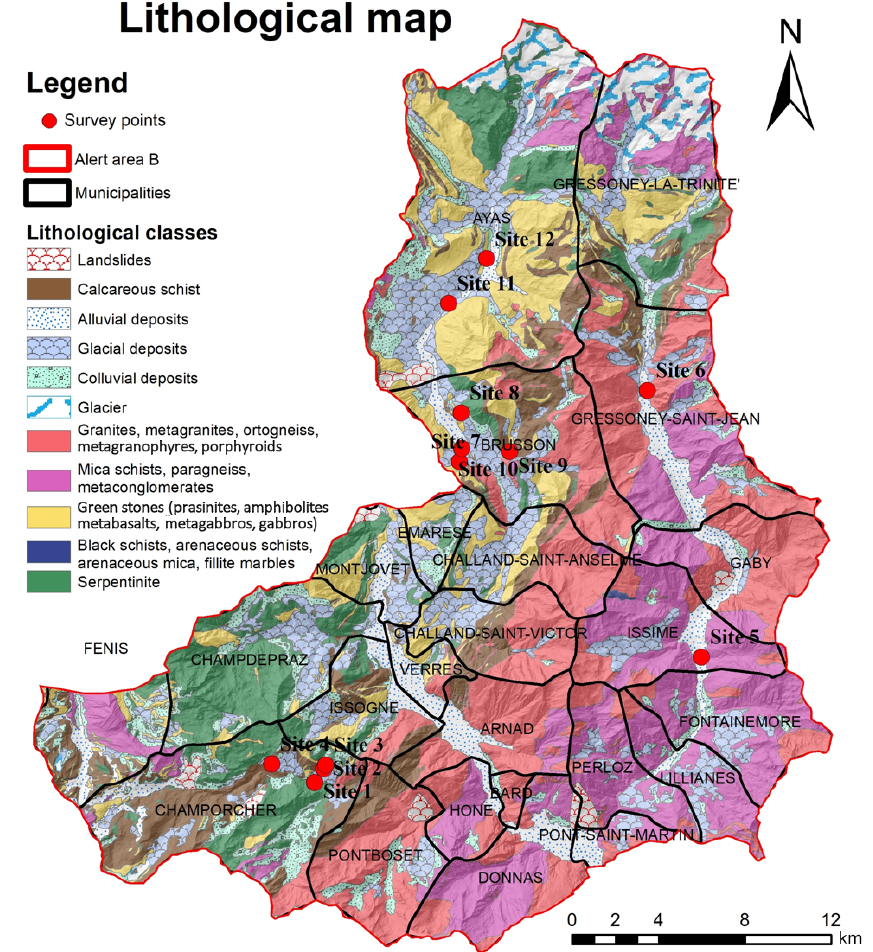
Figure 2. Spatial distribution of survey points compared to the